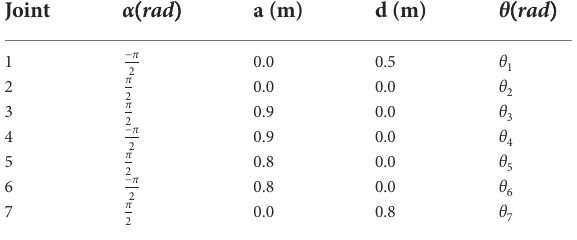
TABLE 1 The DH parameters of the space robot.